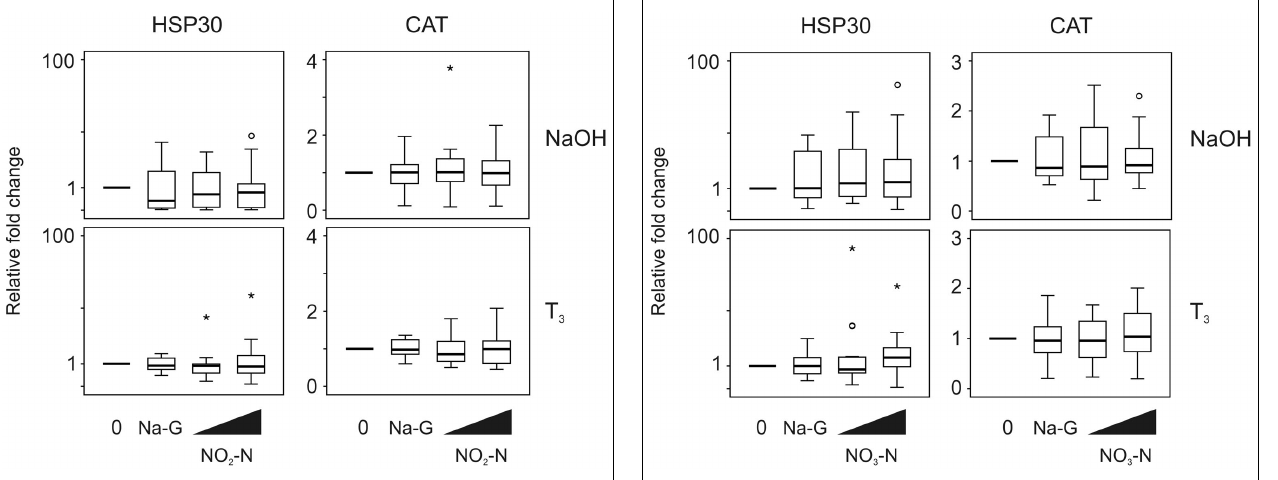
FIGURE 4 | QPCR analysis of heat shock protein 30 ( HSP30 ) and catalase ( CAT ) transcript levels in the C-fin assay after exposure to nitrite in the absence or presence of 10nMT 3 . Tail fin biopsies were exposed to vehicle control (water; 0) and the indicated test chemicals for 48h in the presence of 400nM NaOH or 10nMT 3 in 400nM NaOH solvent. Test chemical concentrations were 5mg/L sodium control (in the form of sodium gluconate, Na-G), 0.5 and 5mg/L NO 2 –N (in the form of NaNO 2 ). The results are expressed as fold change relative to the vehicle control (NaOH; upper panels) or to the vehicle + T 3 -induced levels (lower panels) and represent QPCR data from n = 15–16 animals. Increasing concentrations of test chemicals are represented by bevels. See Figure 1 legend for more details.